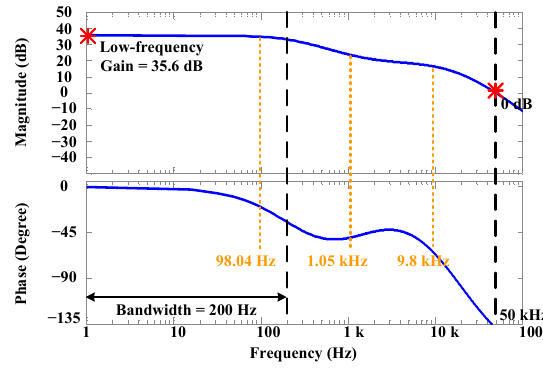
13 of 29 Figure 10. Frequency response simulation using different battery models. Using MATLAB, the frequency response simulation of G oc ( s ) was completed and plotted in Figure 11. In this Bode plot, the low-frequency gain was 35.6 dB, and the bandwidth was 200 Hz. The frequency and phase at 0 dB were 50 kHz and − 140°, respectively. Moreover, at 0.1 to 1 kHz, the gain and phase slopes were − 10.8 dB/decade and − 30.2°/decade; at 1 to 10 kHz, the gain and phase slopes were 7.7 dB/decade and 15.5°/decade, respectively; at 10 to 100 kHz, the gain and phase slopes were − 4.9 dB/decade and − 92.3°/decade, respectively. Furthermore, break frequencies included the f opc 1 = 98.04 Hz (pole), f ozc 1 = 1.05 kHz (zero), and f opc 2 = 9.8 kHz (pole). From Figure 11, three circumstances